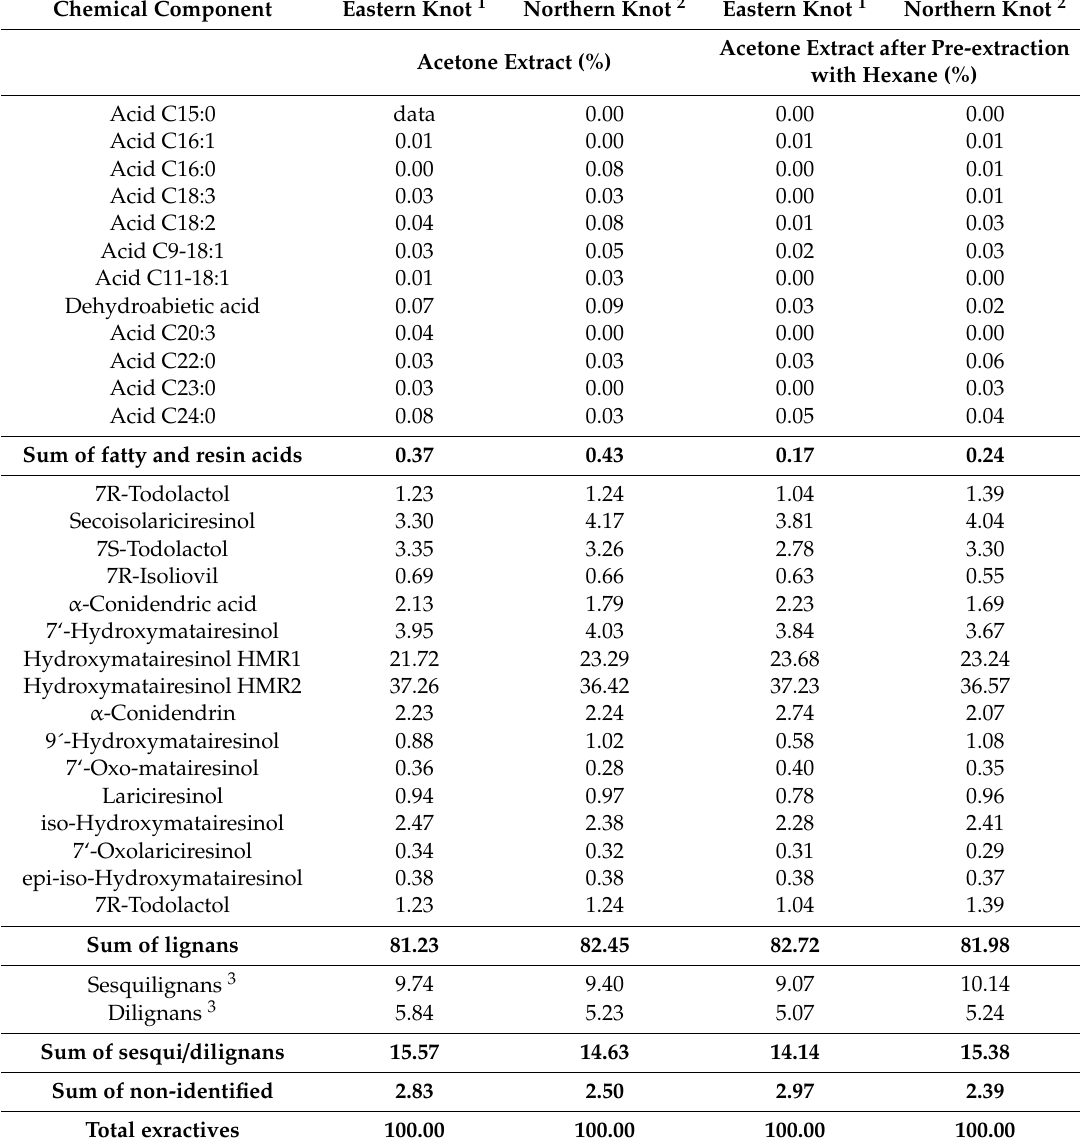
Table 3. Compounds present in the knotwood